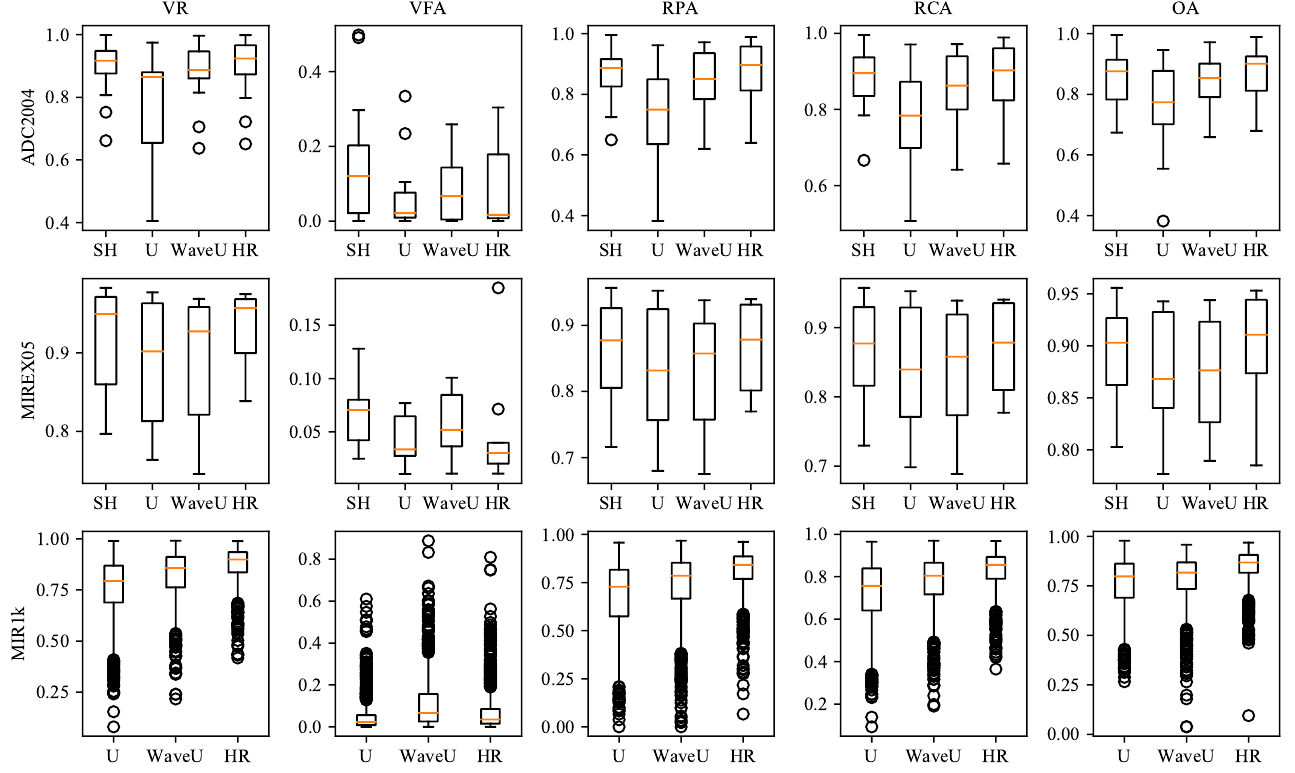
Figure 8. Statistical comparison of different singing voice separation methods for VME on three public